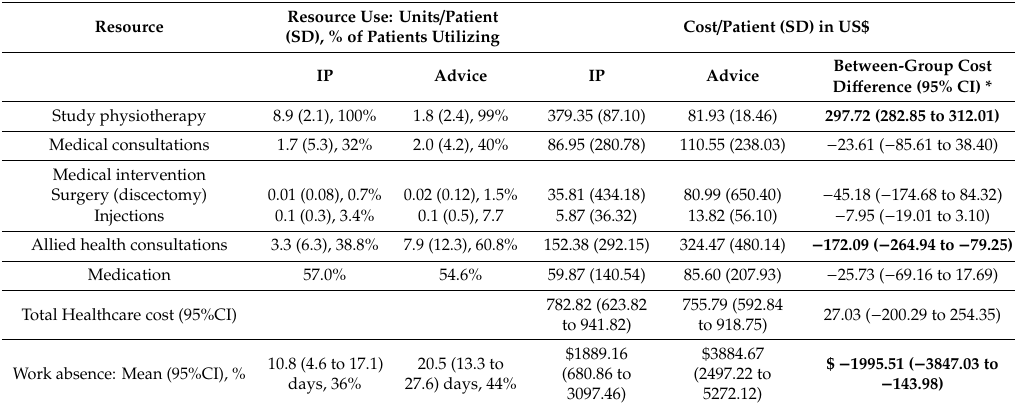
Table 2. Back related healthcare utilization and costs per